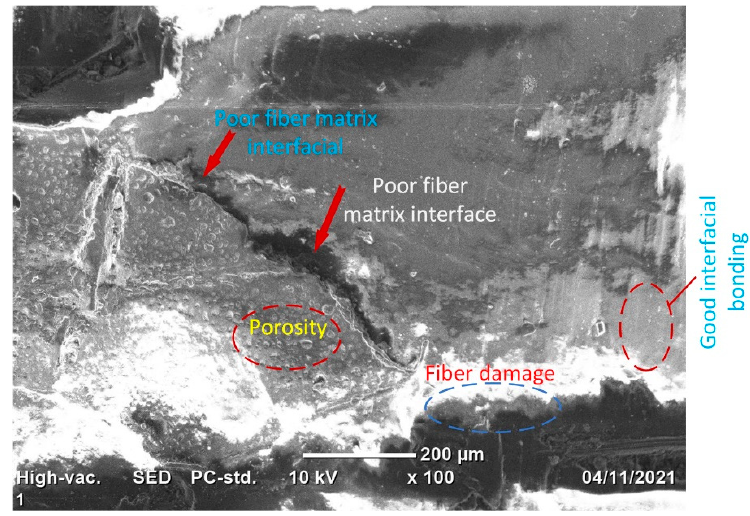
Figure 8. SEM image of 100/0 of enset–sisal hybrid composite.